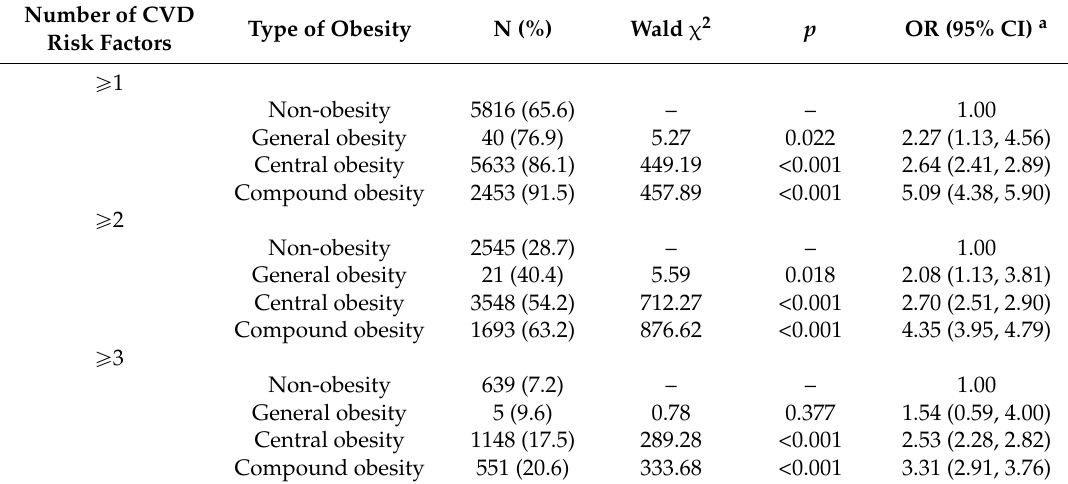
Table 5. Association between the number of clustered CVD risk factors and different types of obesity. Number of CVD